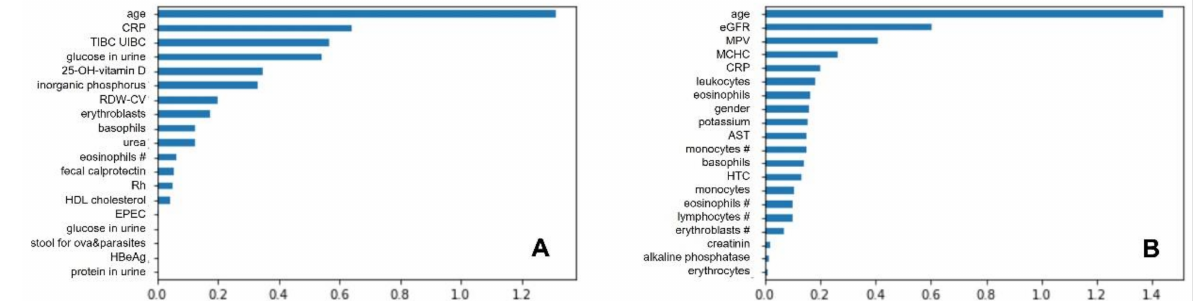
Figure 4. SVC features importance for ulcerative colitis ( A ) and Crohn’s disease ( B ). Abbreviations for ( A ): CRP, C-reactive protein; TIBC, total iron binding capacity; UIBC, unsaturated iron binding capacity; HDL, high-density lipoprotein; Abbreviations ( B ): eGFR, estimated glomerular filtration rate; MPV, mean platelet volume; MCHC, mean corpuscular haemoglobin concentration; CRP, C-reactive protein; AST, aspartate